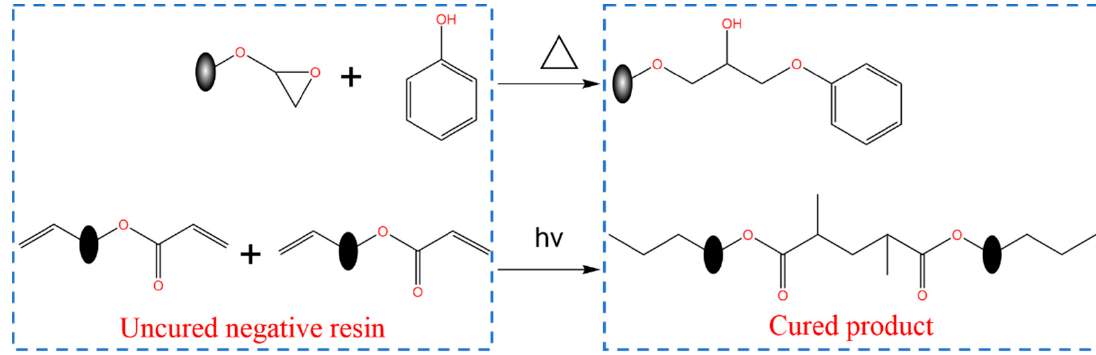
Figure 7. Reaction of fully cured SR3.